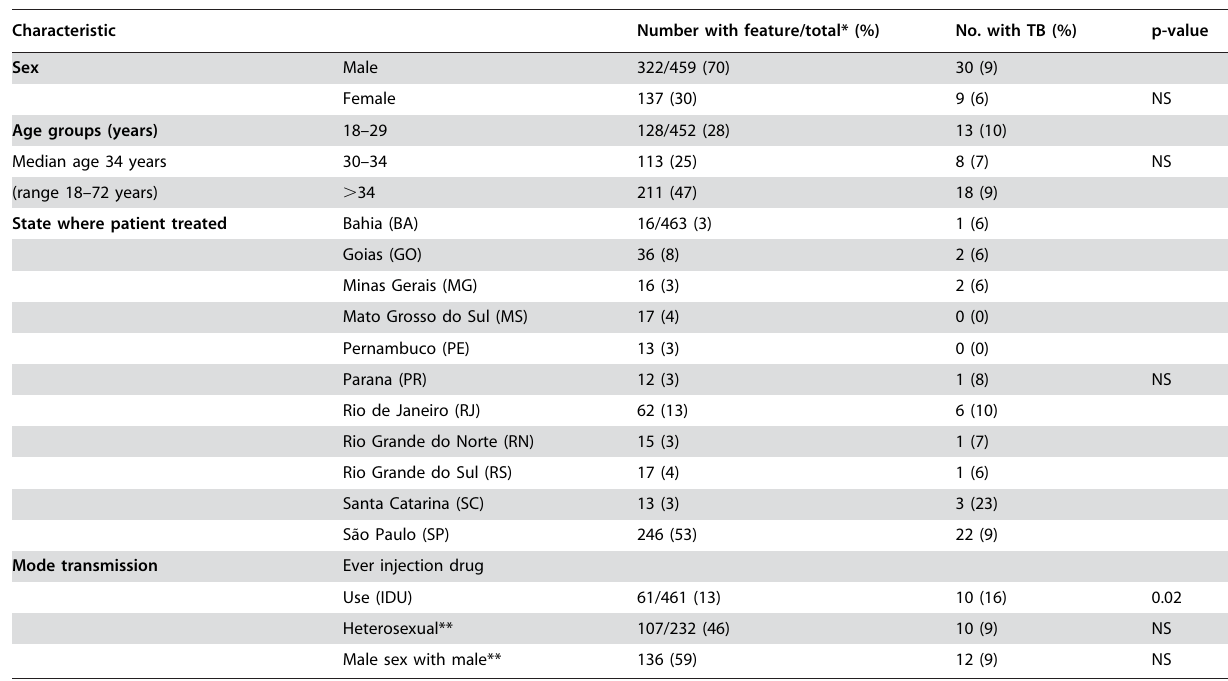
Table 3. Socio-demographic characteristics, by TB status, of patients attending public HIV treatment facilities in Brazil (n=463) between January 1, 1995 and December 31, 2001. .. ... .... ... ... .... ... ... .... ... ... .... ... ... .... ... ... .... ... ... .... ... ... .... ... ... .... ... ... .... ... ... .... ... ... .... ... ... .... ... ... .... ... ... . Characteristic Number with feature/total* (%)